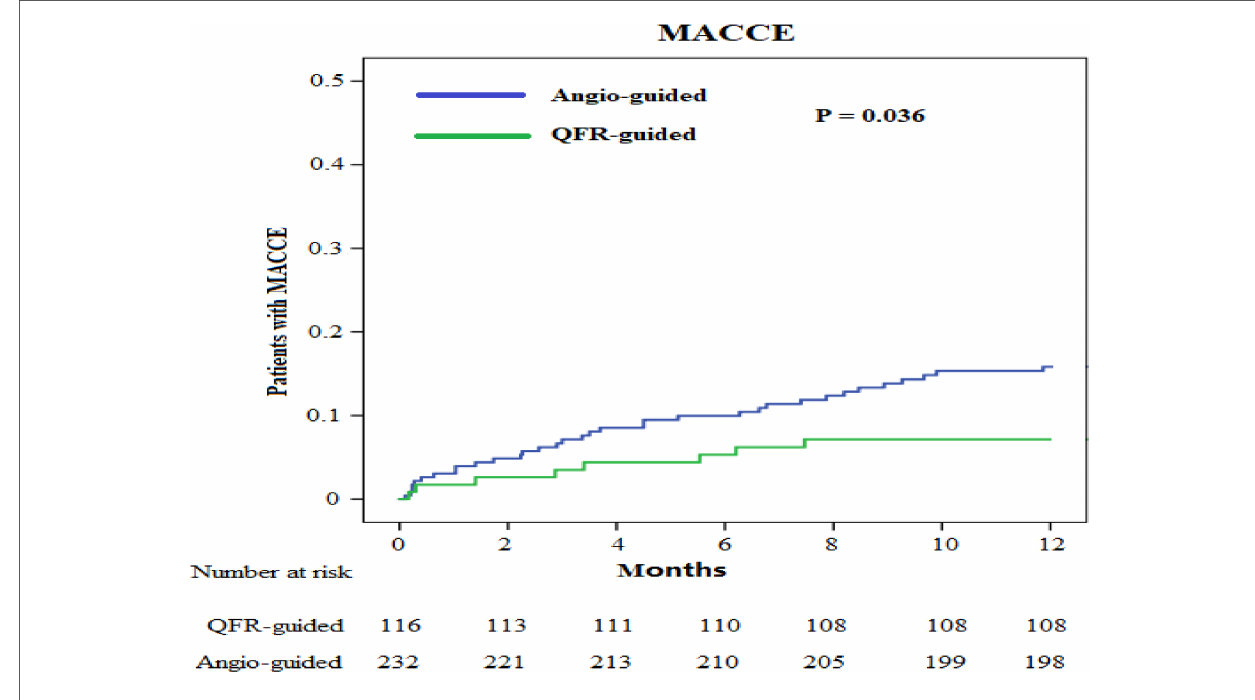
FIGURE 3 Kaplan – Meier curves for the primary